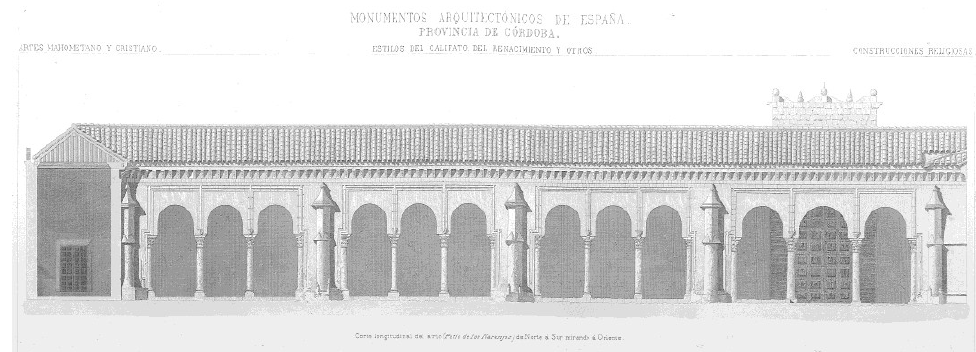
Figure 7. Orange Tree Courtyard. Mosque-Cathedral of Cordoba (B. Arredondo. E. Buxó, secciones (Amador de los Ríos and Amador de los Ríos y Villalta 1879).